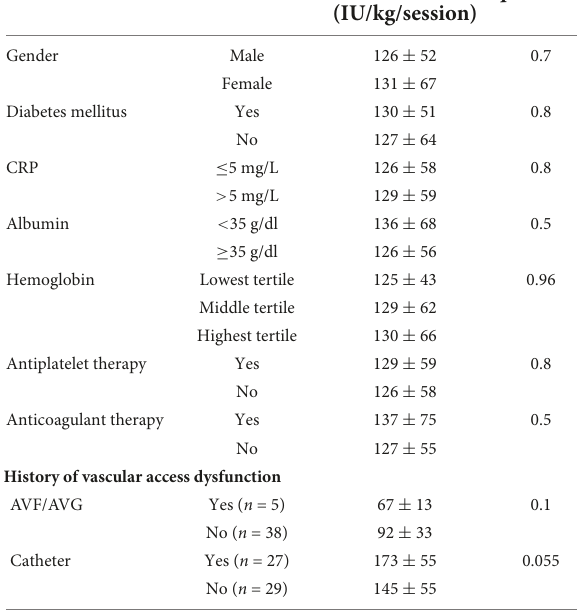
TABLE 2 Total UFH dose per hemodialysis session according to patient characteristics.